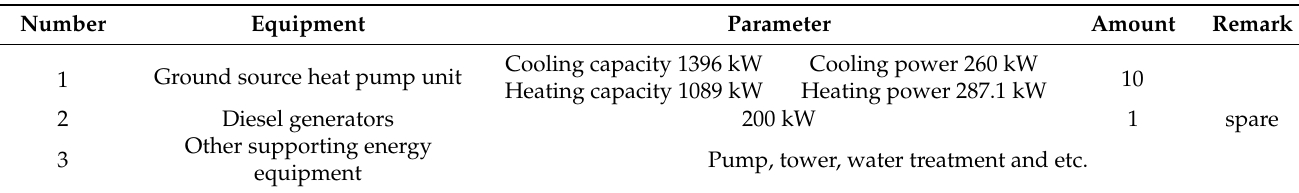
Table A3. Ground source heat pump system main equipment.